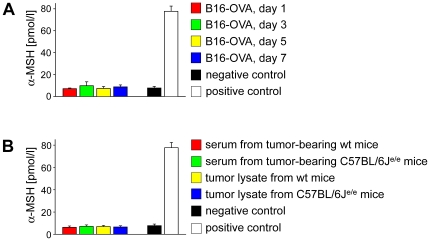
Alpha-MSH is not secreted by B16-OVA melanoma cells or up-regulated in mice bearing B16-OVA tumors.(A) Alpha-MSH was quantified in culture supernatants from B16-OVA melanoma cells at indicated time points by radioimmunoassays. (B) Alpha-MSH was quantified in the serum as well as in tumor lysates from tumor-bearing wt and C57BL/6Je/e mice 21 days after subcutaneous injection of 100,000 B16-OVA melanoma cells (n = 5 mice each group).